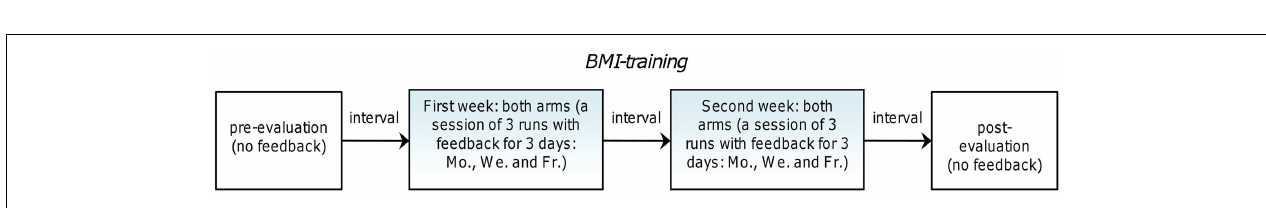
FIGURE 3 | Experimental protocol . Interval between blocks consisted of 2days.